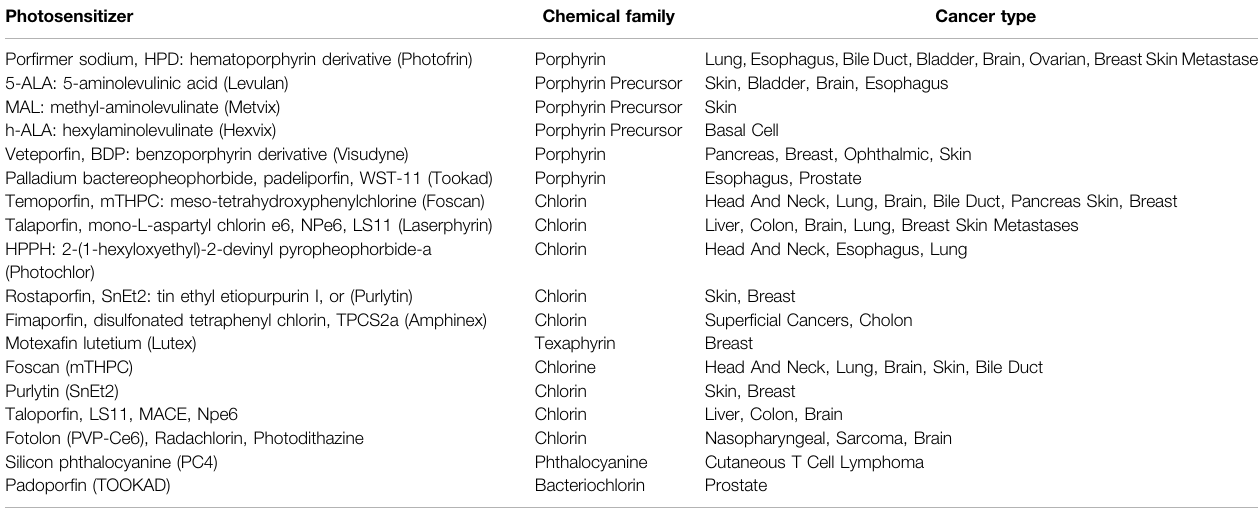
TABLE 1 | Photosensitizers investigated in clinical trial for cancer treatment a (Chen et al., 2001; Pogue et al., 2001; Cramers et al., 2003; Agostinis et al., 2011, 2012; Lamberti et al., 2014; Bacellar et al., 2015; Spring et al., 2016; Banerjee et al., 2017; Kwiatkowski et al., 2018; Dos Santos et al., 2019). Photosensitizer